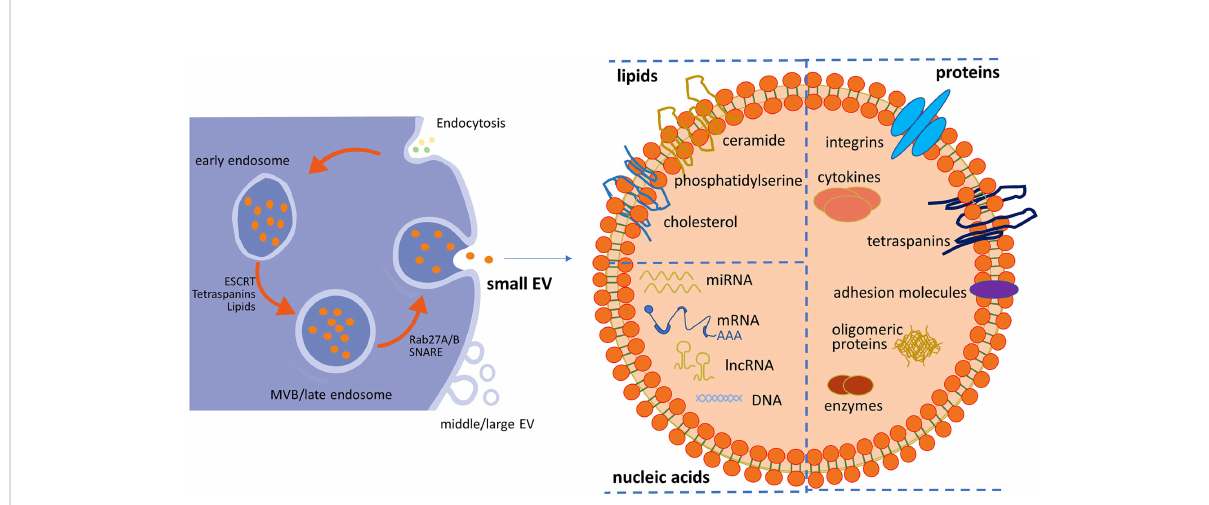
FIGURE 1 Schematic representation of small EV (sEV) biogenesis and typical structure of sEVs. Within the endosomal system, internalized contents through endocytosis are sorted into early endosomes, which subsequently mature into late endosomes/multivesicular bodies (MVBs). sEVs are released from the fusion of MVBs and the plasma membrane. sEVs accommodate lipids, nucleic acids (DNA, mRNA, and non-coding RNA), and proteins (surface and intra-vesicular molecules). Middle/large EVs bud directly from the plasma membrane. EV, extracellular